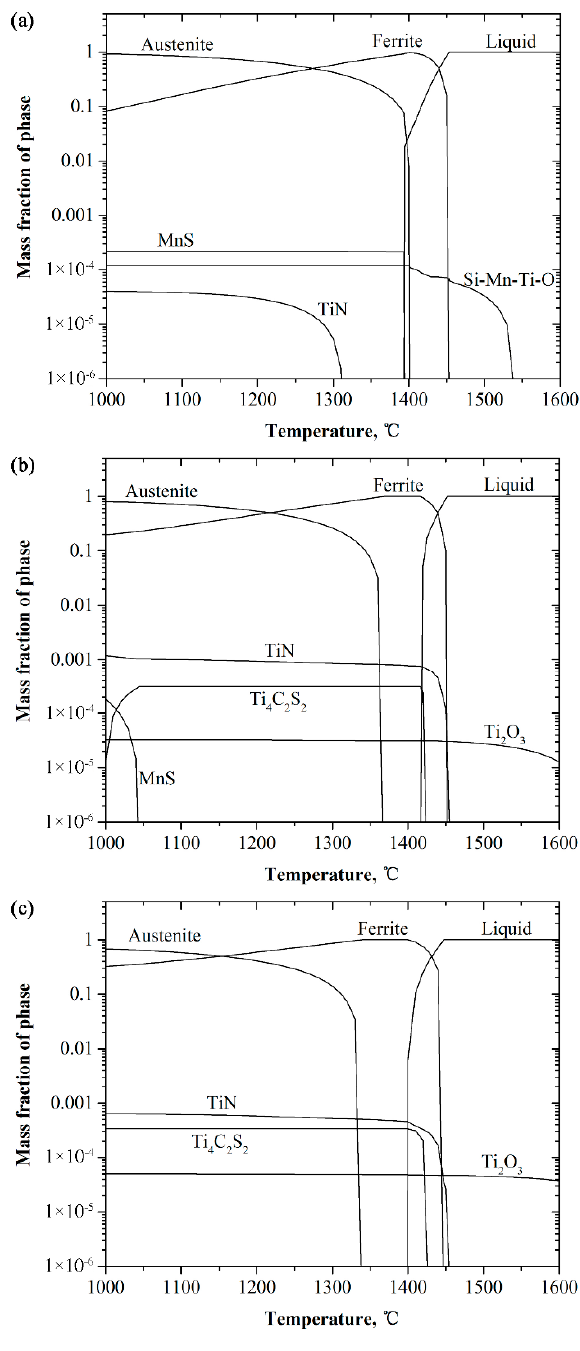
Figure 13. Equilibrium thermodynamic analysis in the solidification process of 20Cr-8Ni stainless steel: ( a ) S1; ( b ) S2; and ( c ) S3.